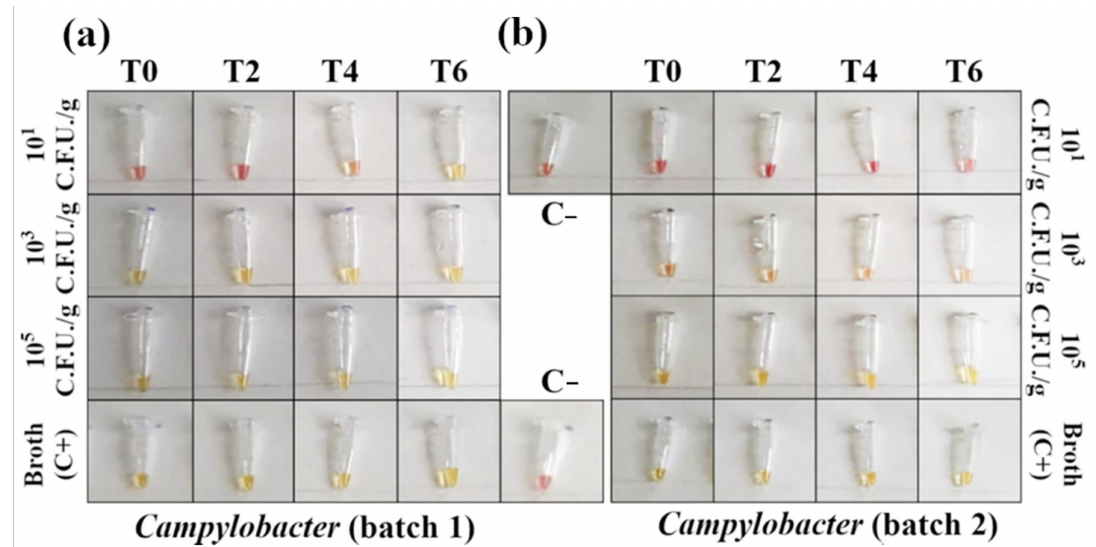
Figure 6. Detection of Campylobacter spp. DNA in contaminated minced chicken meat using colorimetric LAMP (ampli- fication time 45 (cid:48) ). Negative samples are red and positive samples are yellow. ( a ) In the first batch of minced meat, the reaction detected 10 1 CFU/g after 4 h of enrichment. ( b ) For the second batch, 10 3 CFU/g were detected with no need for enrichment. Only one out of three replicates is shown here for each sample (see Figures S7 and S9 for the complete